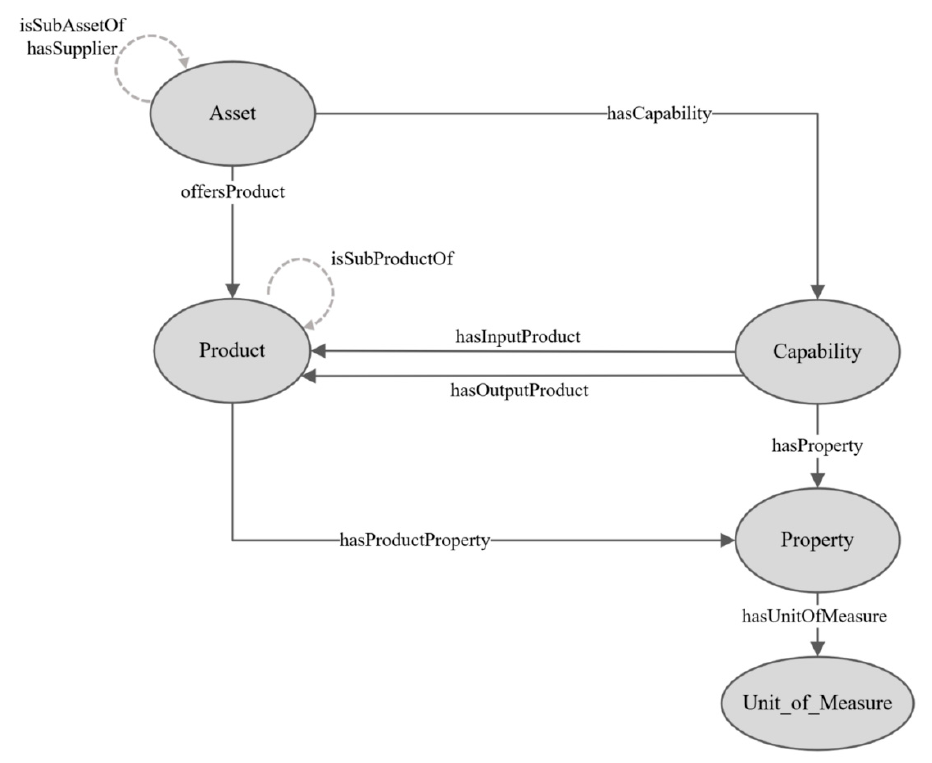
Figure 5. Smart Factory Web ontology.